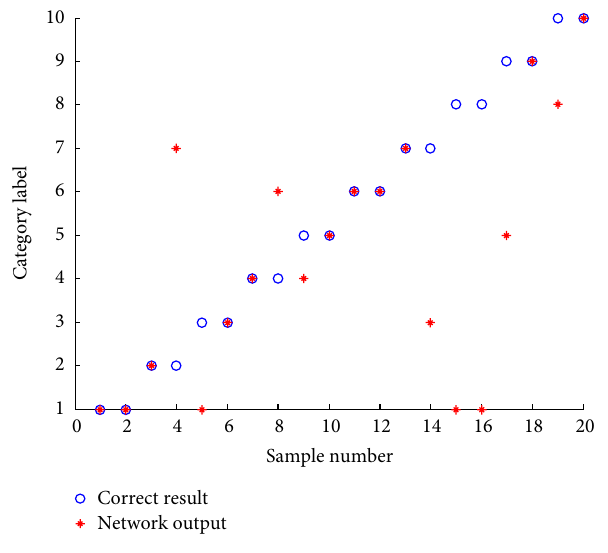
Figure 6: Detection results of LVQ network.